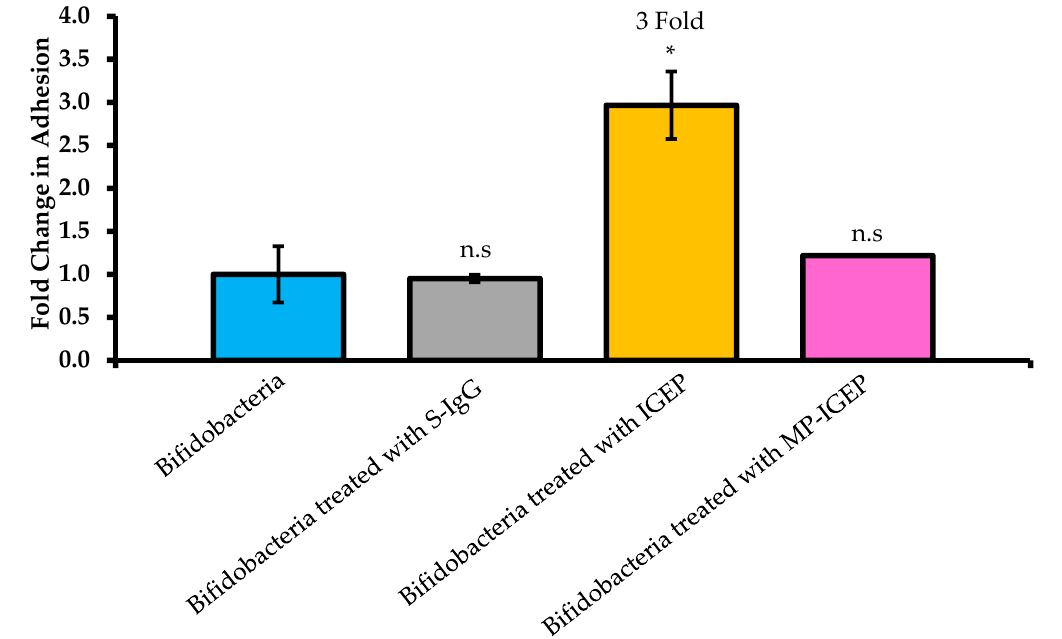
Figure 2. Adhesion of Bifidobacterium infantis to HT-29 cells following incubation with bovine serum-derived IgG (S-IgG), whey-derived Ig enriched powder (IGEP), and metaperiodate-treated IGEP (MP-IGEP). Results are from three biological replicate experiments, each performed in technical triplicate, except for S-IgG and MP-IGEP treatment which were assayed in technical triplicate using one biological replicate. Results were calculated as the percentage of adherent cells = (CFU / mL of recovered adherent bacteria ÷ CFU / mL of inoculum) × 100, and bars represent the fold-change relative to percent adhesion of control, with error bars representing ± one standard deviation. The Student t- tests were used to test for significance in comparison to the control (Bifidobacteria). *, p -value < 0.05; n.s., not